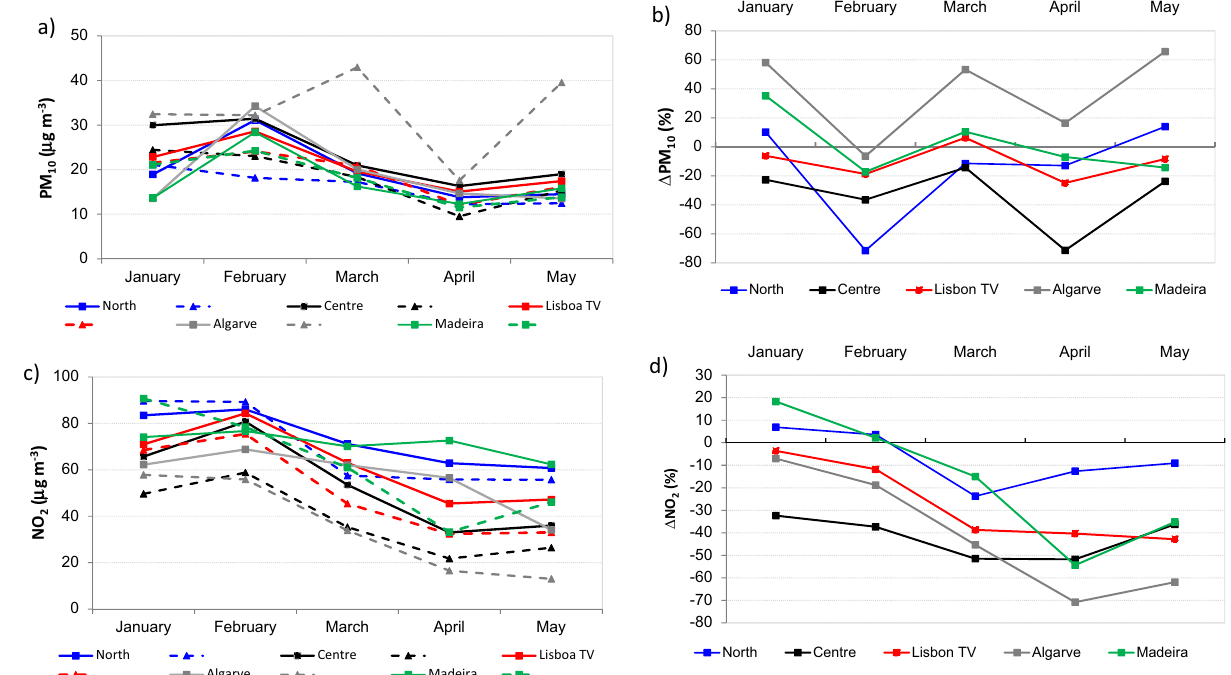
Figure 2. Assessment of traffic related pollution of PM 10 and NO 2 , ( a ), ( c ) monthly profiles (January–May) in 2019 and 2020; ( b ) and ( d ) representations of pollutant concentration changes in 2020 vs . 2019. Dashed lines represent 2020 values whereas continuous lines represent levels in 2019. Monthly means were estimated across 22 urban/traffic monitoring